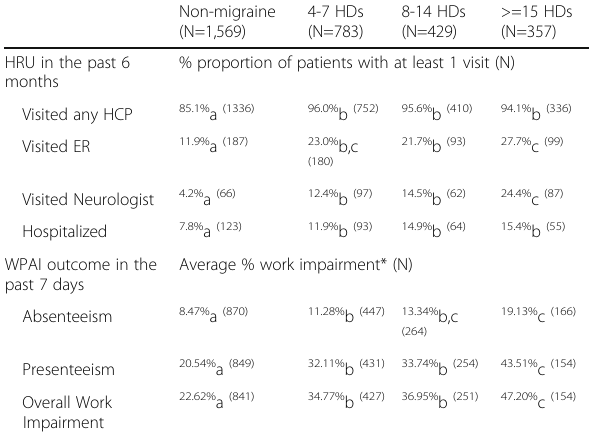
Table 1 (abstract P39). HRU and WPAI outcomes after propensity score matched